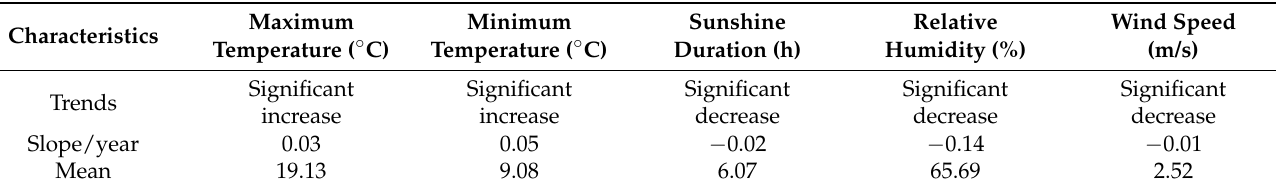
Table 1. Variation characteristics of meteorological factors from 1981 to 2019 in the lower reaches of the Yellow River Basin. A significance level of 0.05 was